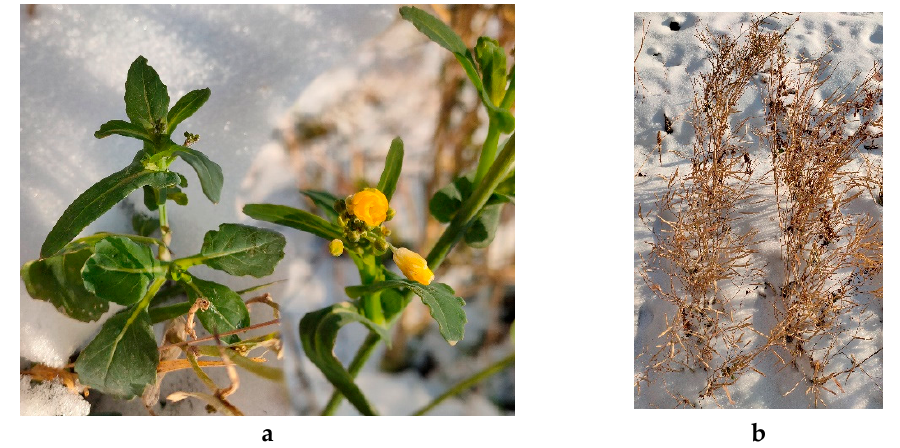
Figure 9. Transgenic ( a ) and WT plants ( b ) in experimental plot in November.